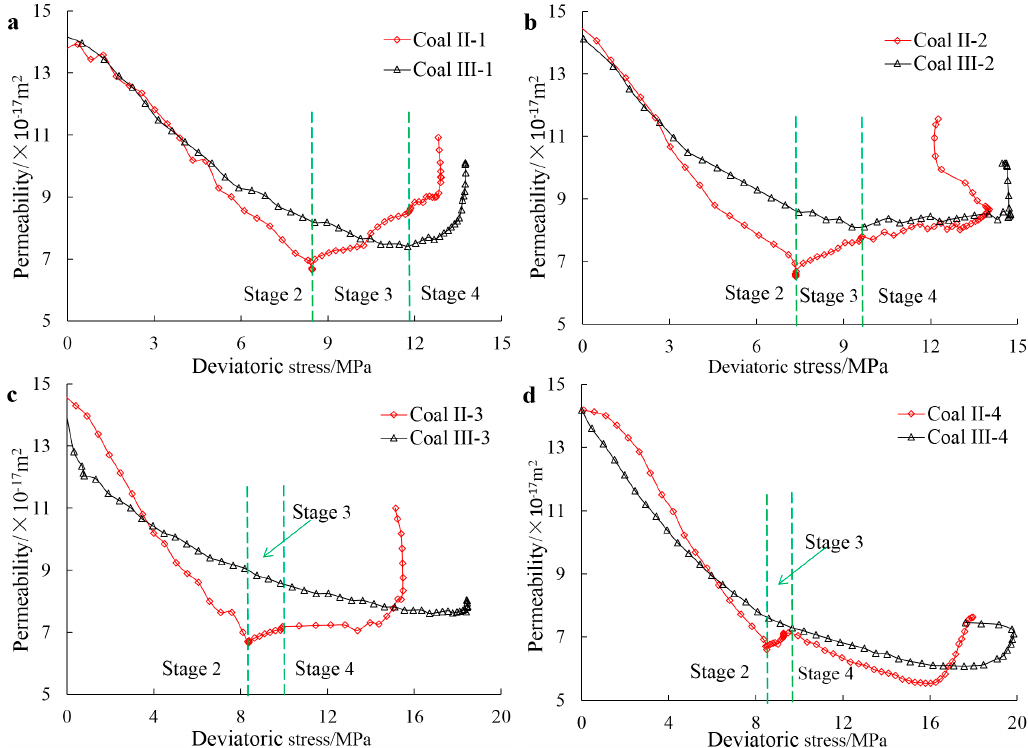
Figure 12. Permeability evolution with deviatoric stress: ( a ) for coal II-1 and III-1; ( b ) for coal II-2 and III-2; ( c ) for coal II-3 and III-3; ( d ) for coal II-4 and III-4 (Stage 2, Stage 3, and Stage 4 with reference to Stress Path II).